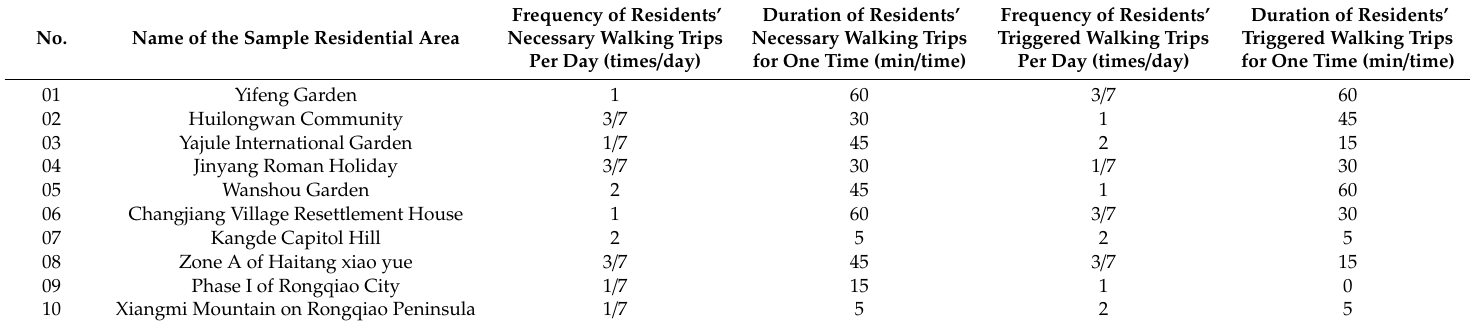
Table A1. Walking time statistics of residents’ walking trips in sample residential